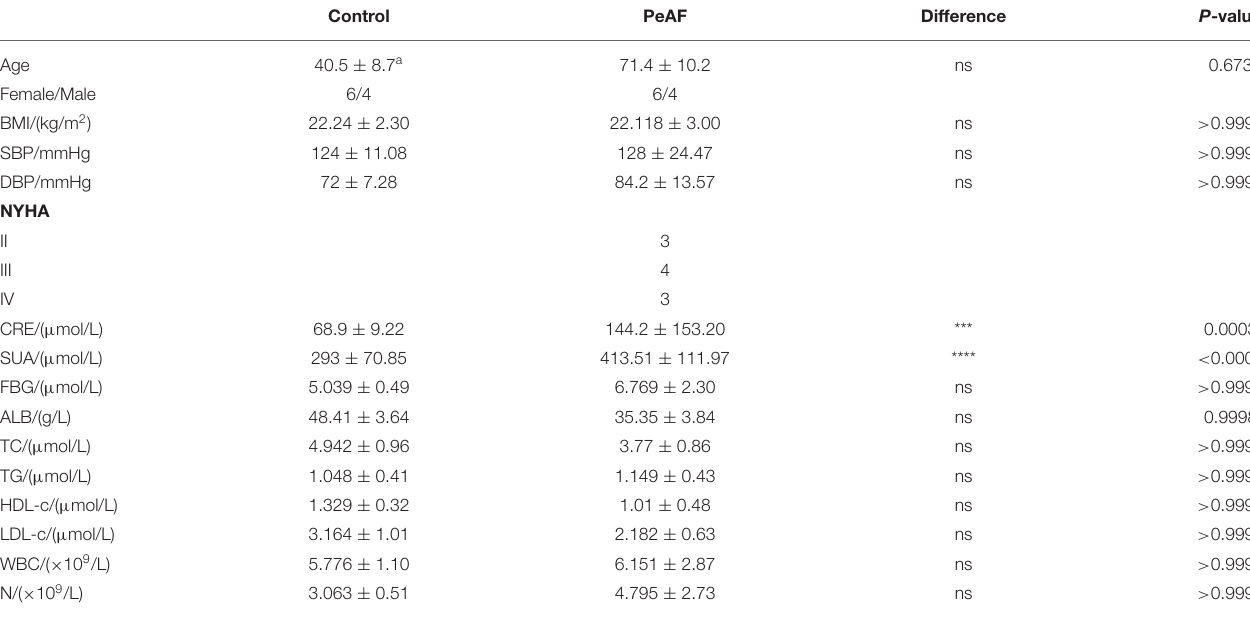
TABLE 1 | Baseline characteristics of